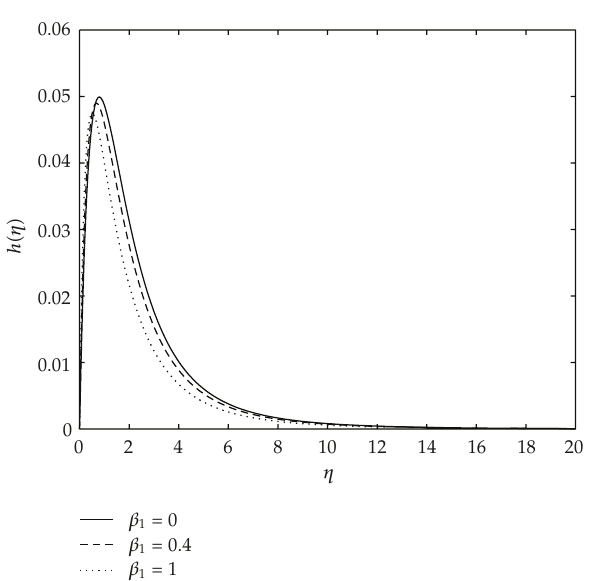
Figure 5: Transverse velocity profiles for various values of β 1 with M (cid:5) 1, Pr (cid:5) 0 . 72, m (cid:5) 1, β 2 (cid:5) 0 . 1, and S (cid:5) 0 . 8 .